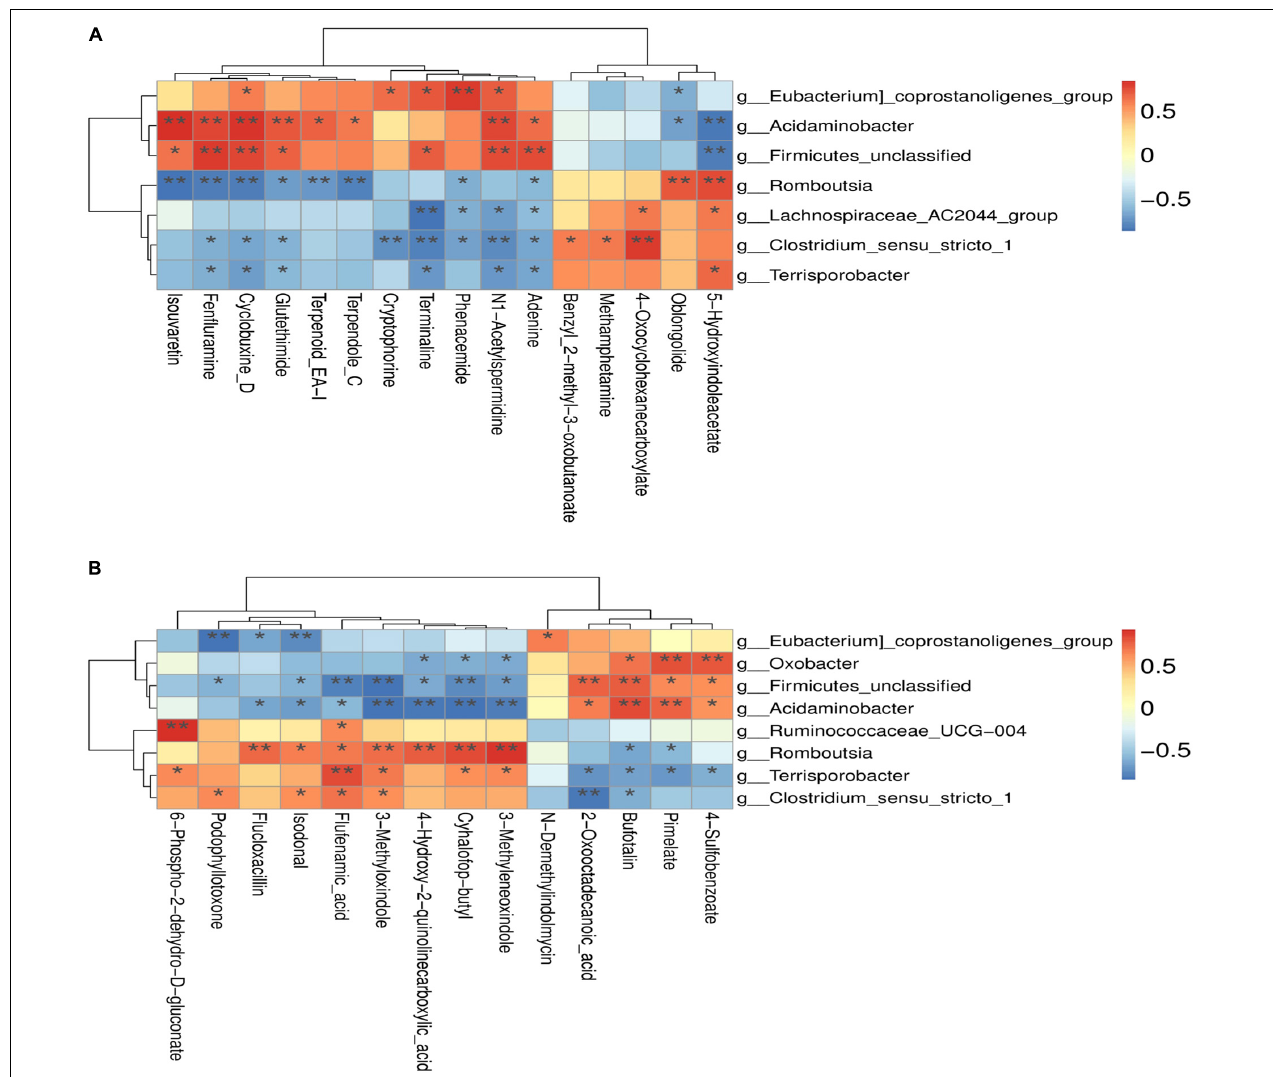
FIGURE 6 | (A) Positive model; (B) negative model. (A) The correlation between positive ion metabolites and differential flora; (B) the correlation between negative ion metabolites and differential flora. * p -value < 0.05; ** p -value <